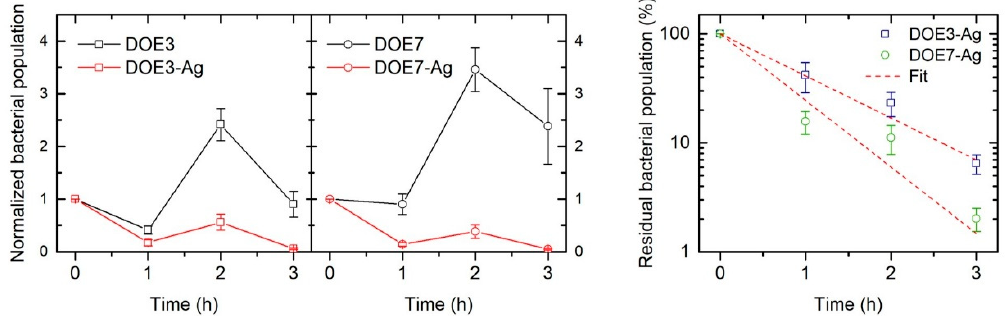
Figure 14. Left panel: Bacterial population on uncoated (black points) and coated (red points) samples normalized with respect to the E. coli control culture as a function of time. Right panel: Percentage residual bacterial population on the Ag-coated samples with respect to the corresponding uncoated samples for DOE3 (blue squares) and DOE7 (green circles) as a function of time, together with exponential decay fit (dotted red